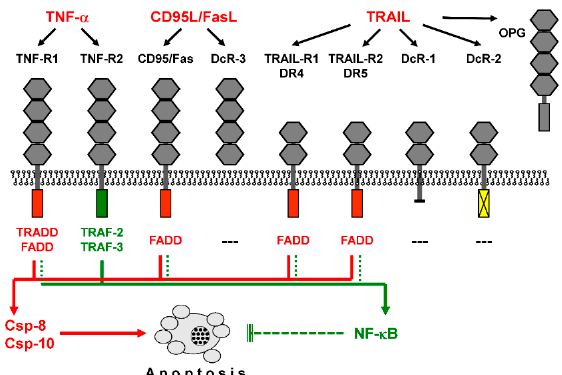
Figure 1. Death receptors activate proapoptotic caspase cascades as well as NF- κ B. Binding of